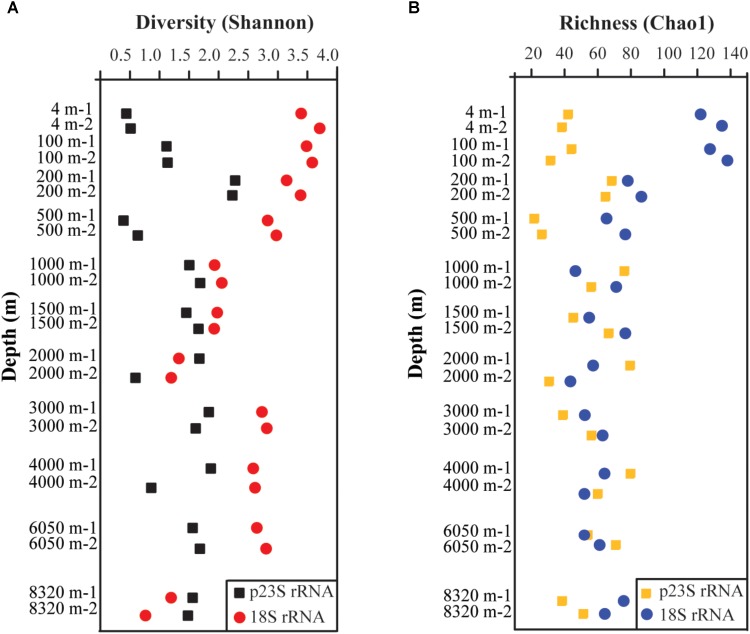
Vertical distribution patterns of diversity (Shannon) (A) and richness (Chao1) (B) of 18S and p23S rRNA gene analysis for PN.